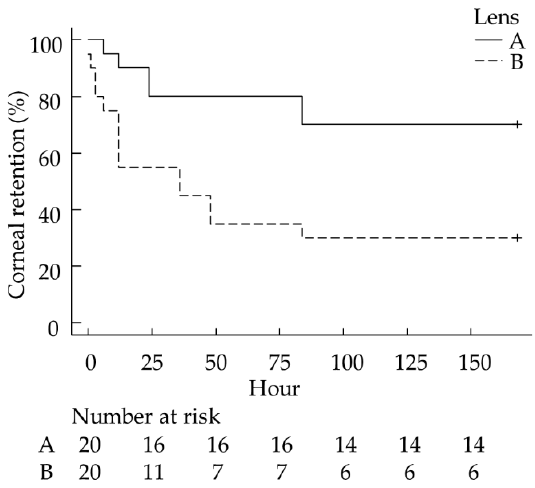
Figure 1. Kaplan – Meier curves for the retention rate of each BCL. The A lens had a significantly higher retention rate than the B lens ( p = 0.006). BCL, bandage contact lens. The experiment was conducted once using 20 A lenses and 20 B lenses.